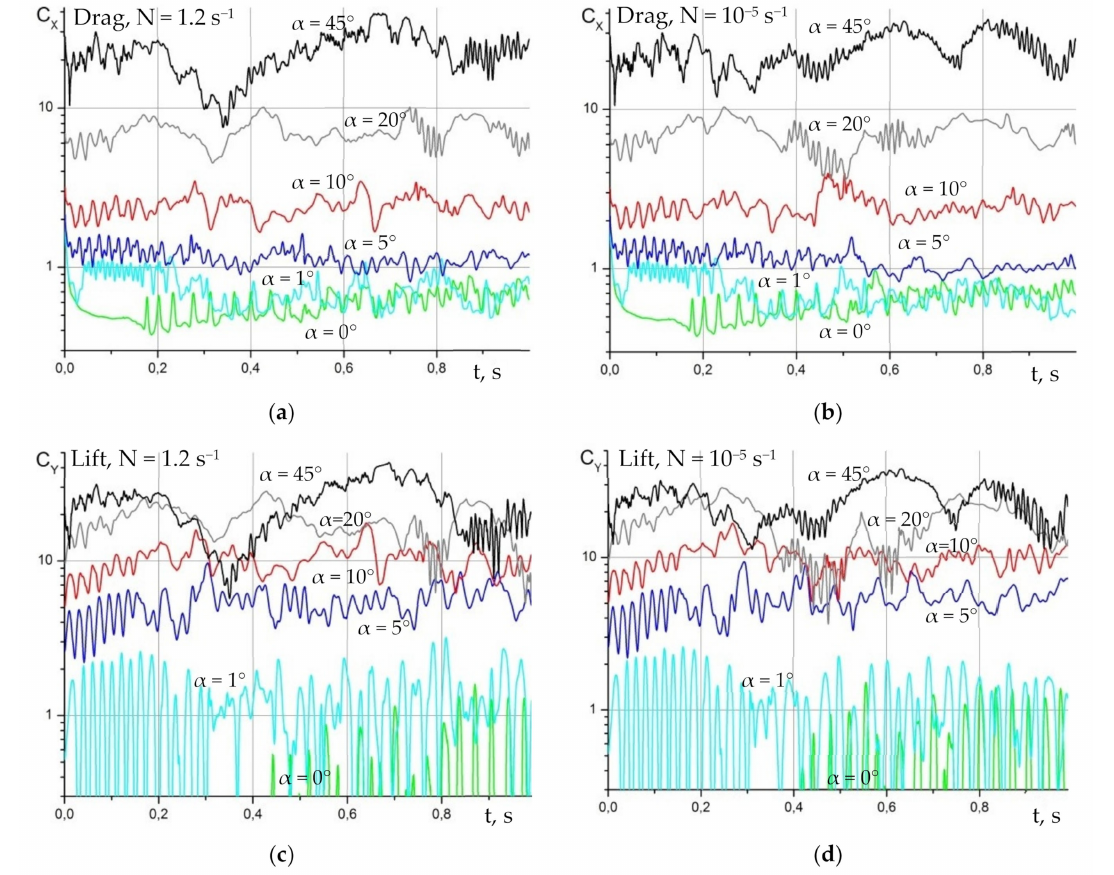
Figure 16. Integral values of drag ( a , b ) and lift ( c , d ) coefficients on a tilted plate in strongly stratified ( a , c ) N = 1.2 s − 1 , and potentially homogeneous ( b , d ) N = 10 − 5 s − 1 fluids as functions of time for different tilt angles of the plate, L = 10 cm, U = 100 cm/s, α = 0, 1.0, 5.0, 10, 20, 45 ◦ .